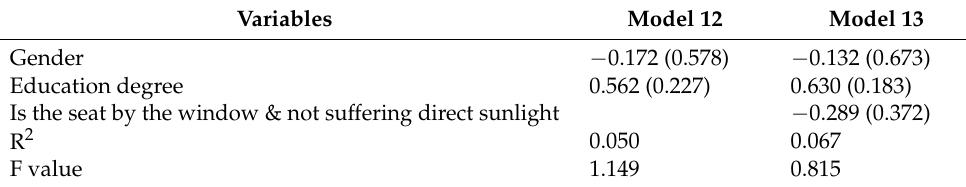
Table 5. Post hoc analysis on unit 2 with “Learning experience” as the dependent variable (N = 280).